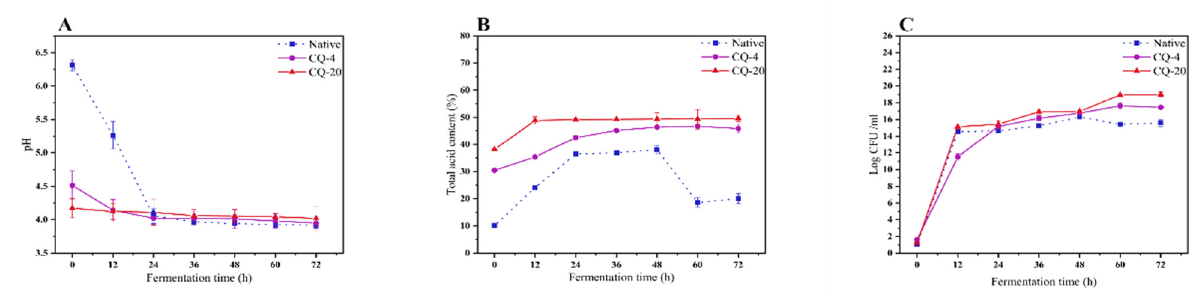
Figure 4. Fermentation time-dependence of pH ( A ), total acid content ( B ), and viable cell count ( C ) in Native, CQ − 4, CQ − 20 samples fermented by Lactobacillus plantarum NO.2 at 34 °C. Native: native quinoa flour; CQ − 4: quinoa flour cold stress treated at 4 °C; CQ − 20: quinoa flour cold stress treated at − 20 °C. Values are reported as mean ± standard deviation.